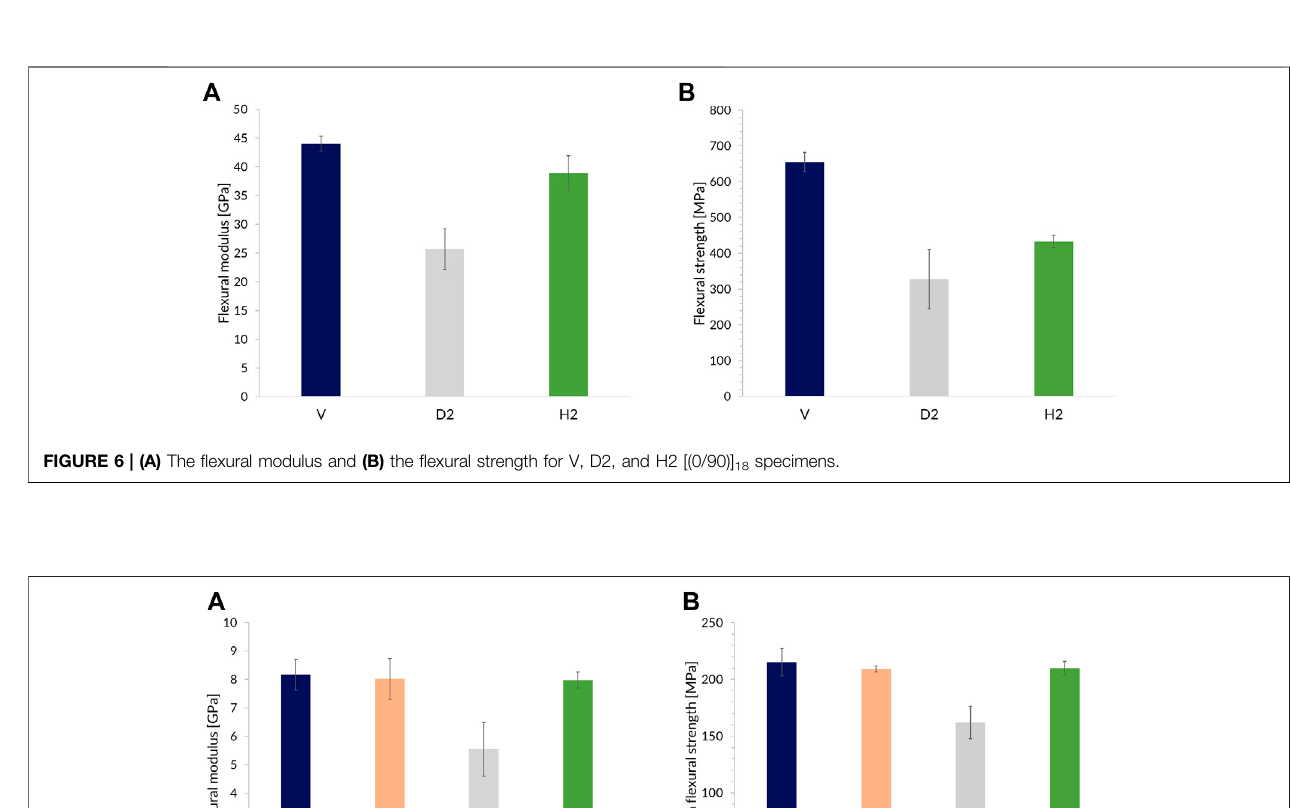
FIGURE5| Picturesofthe[(+45/ − 45)] 18 samplesduringthe fl exuraltestsdepictingthetypicalfailuremodeof (A) Vand (B) VC, (C) and (D) D2,and (E) H2samples.